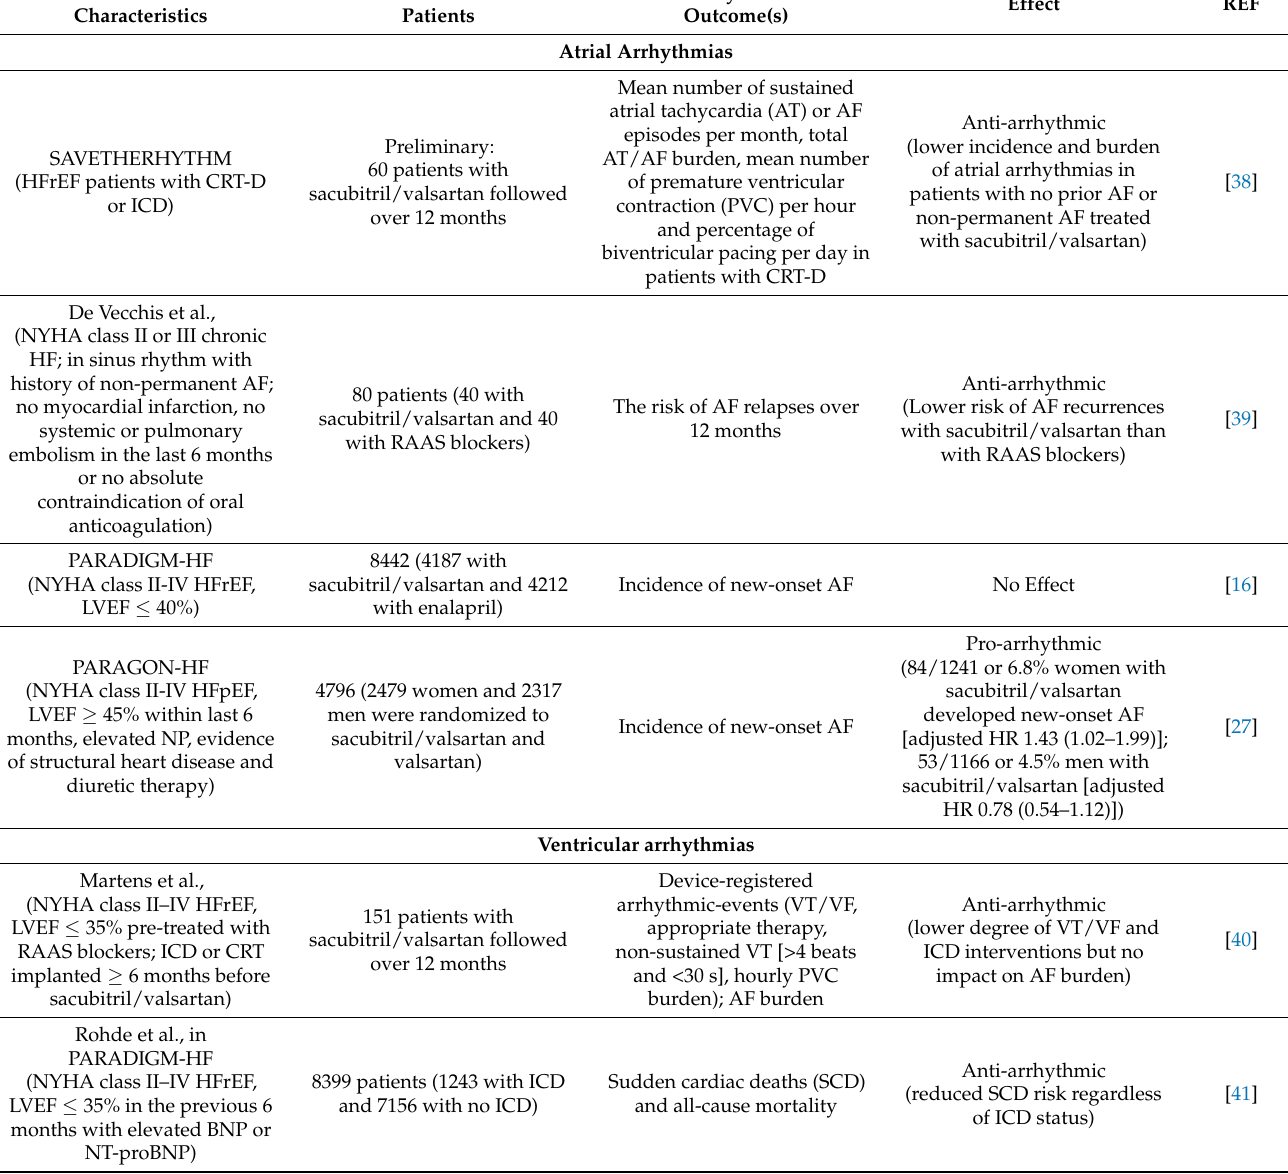
Table 1. Clinical evidence on the proarrhythmic and antiarrhythmic effects of